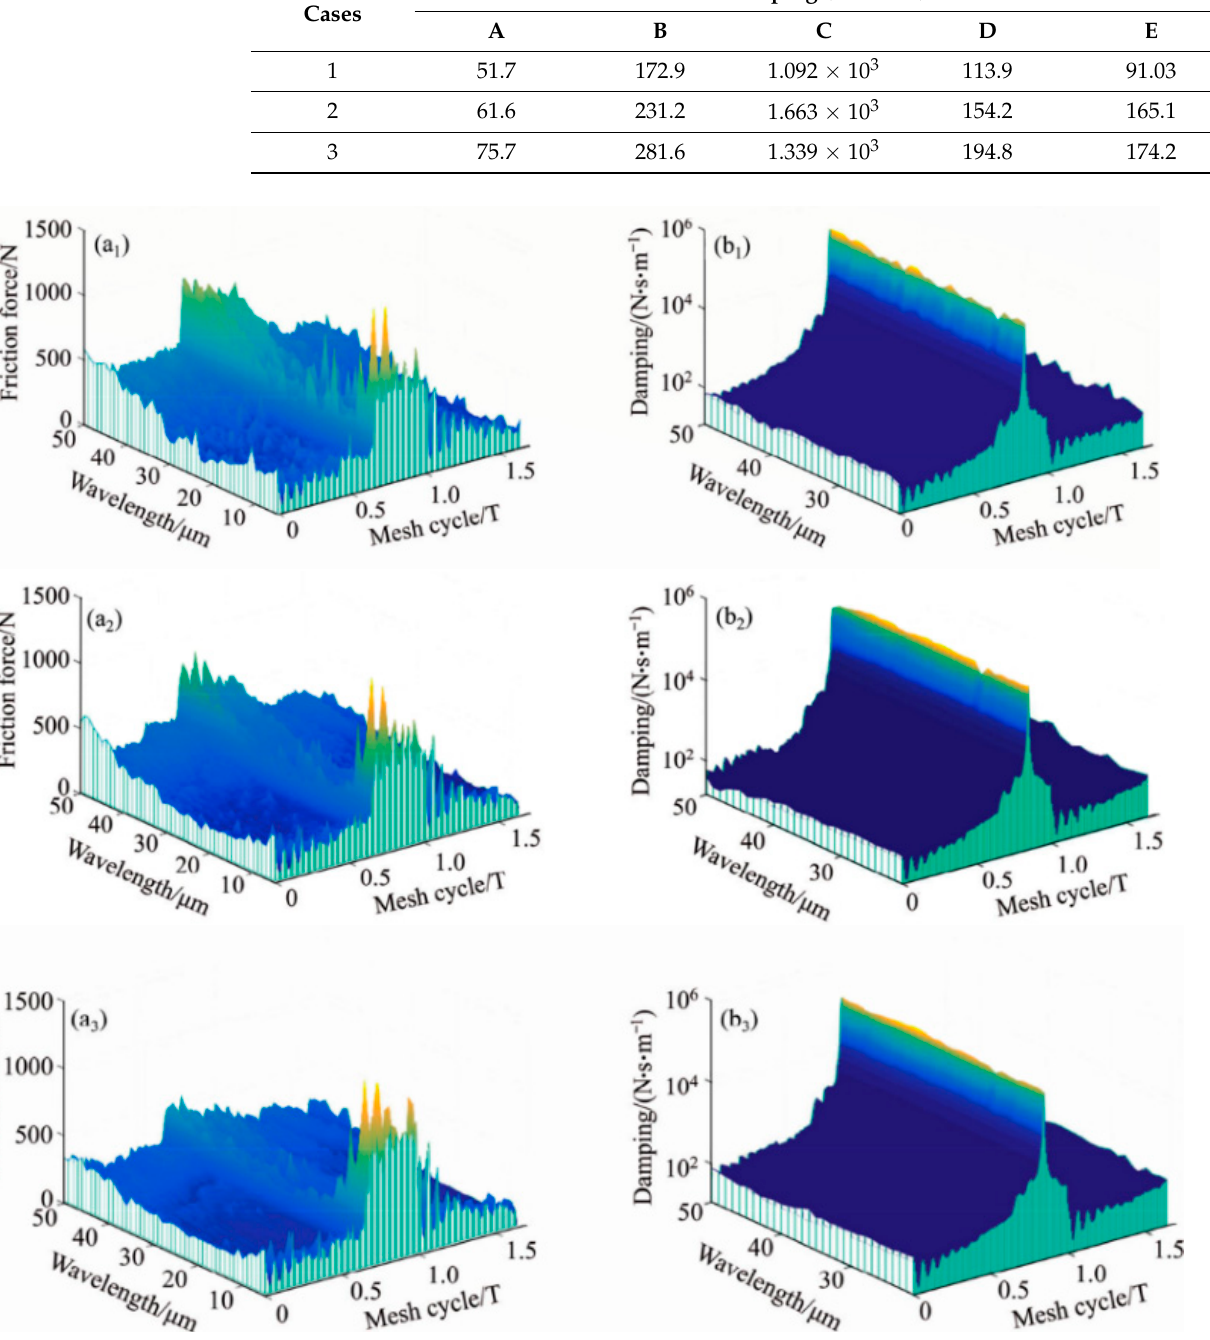
Figure 11. Transient friction force and time-varying viscous damping with CIMT cases of MGPs of multiplex wavelengths ( a 1 , b 1 ) Case 1, ( a 2 , b 2 ) Case 2, ( a 3 , b 3 ) Case